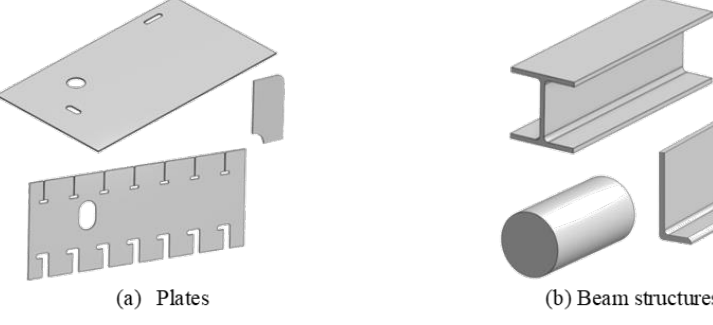
Figure 7. Examples of mirroring type part.